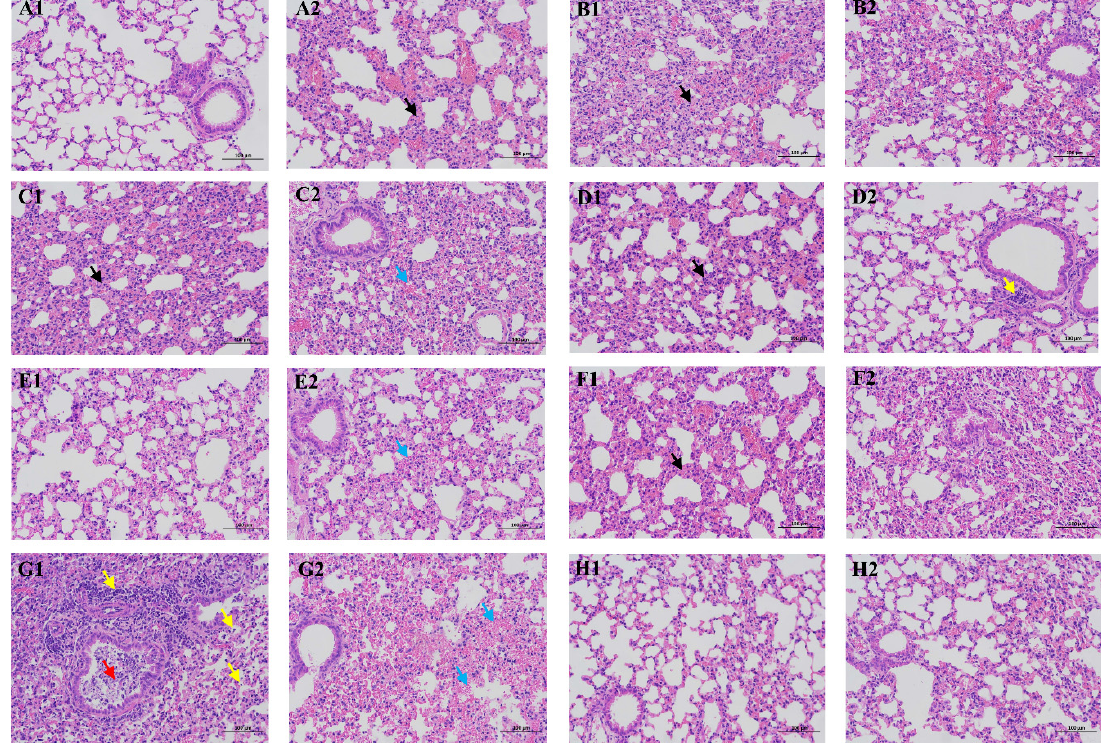
Figure 4. Representative histopathological changes in H&E-stained lung sections from mice infected with the indicated viruses at 3 dpi. Scale bar = 100 µm. Black arrows indicate alveolar walls with mild or moderate thickening. Blue arrows indicate alveolar walls with mild or moderate congestion and even bleeding. Yellow arrows indicate inflammatory cells that exhibit a small amount of effusion or point infiltration and even form inflammatory cuffs. Red arrows indicate necrotic cell debris. A-H: A1 indicates the control group. A2 and B to H indicate lung sections of mice infected with CK/SD/1286/16, CK/SD/3424/16, DC/SD/915/17, DC/SD/1432/17, CK/SD/1646/18, CK/SD/1647/18, CK/SX/1757/19, or CK/SD/1834/19.